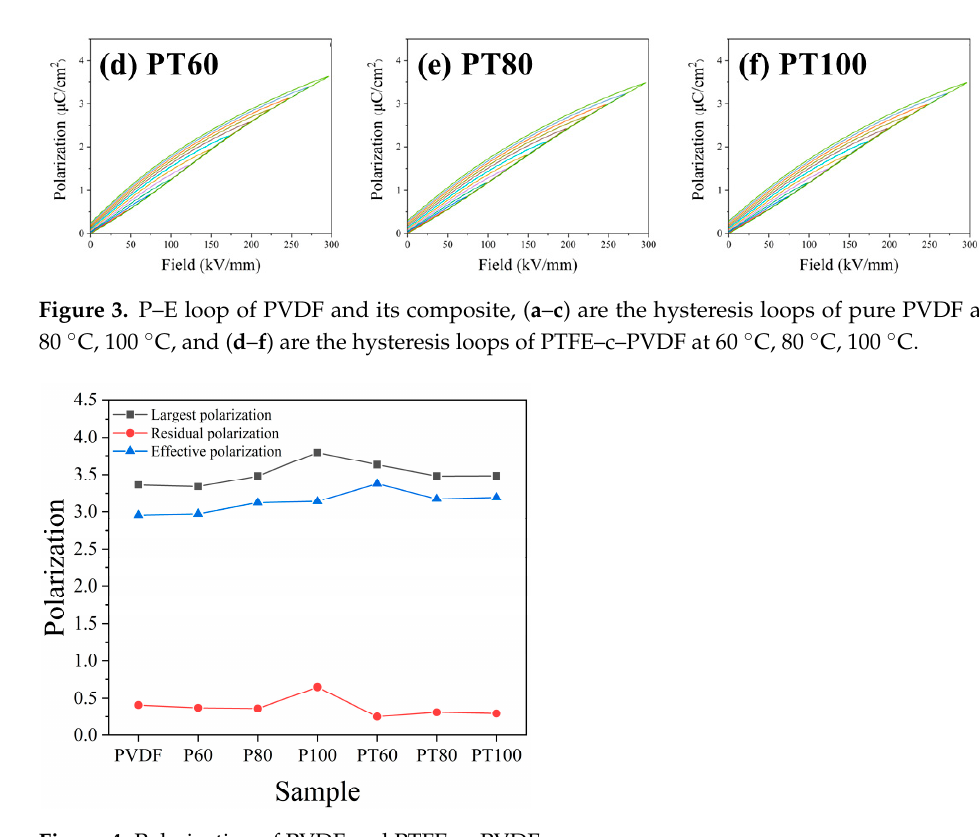
Figure 4. Polarization of PVDF and PTFE–c–PVDF .